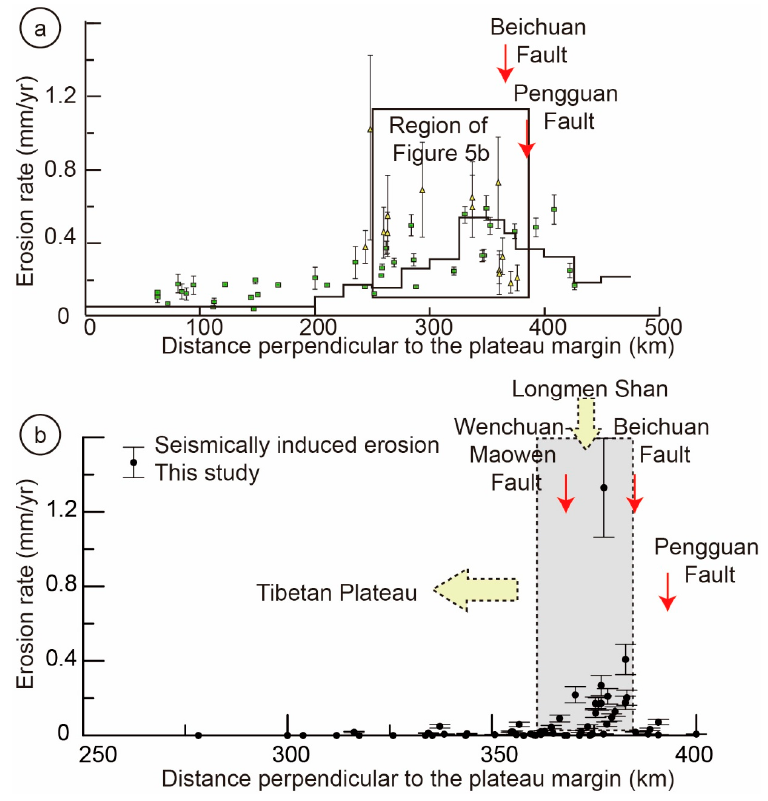
Figure 5. ( a ) Distribution of short-term erosion rates from previous studies (modified from Reference [24]) and ( b ) seismically- induced erosion rates from this